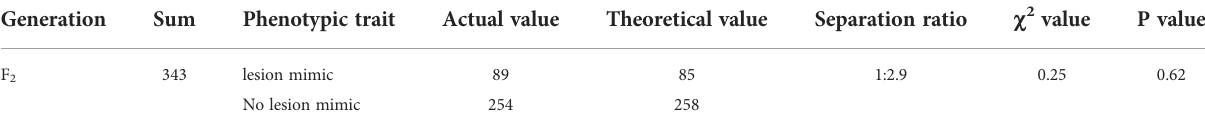
TABLE 1 The genetic analysis of lesion mimic 5386/Morex F2 population. Generation